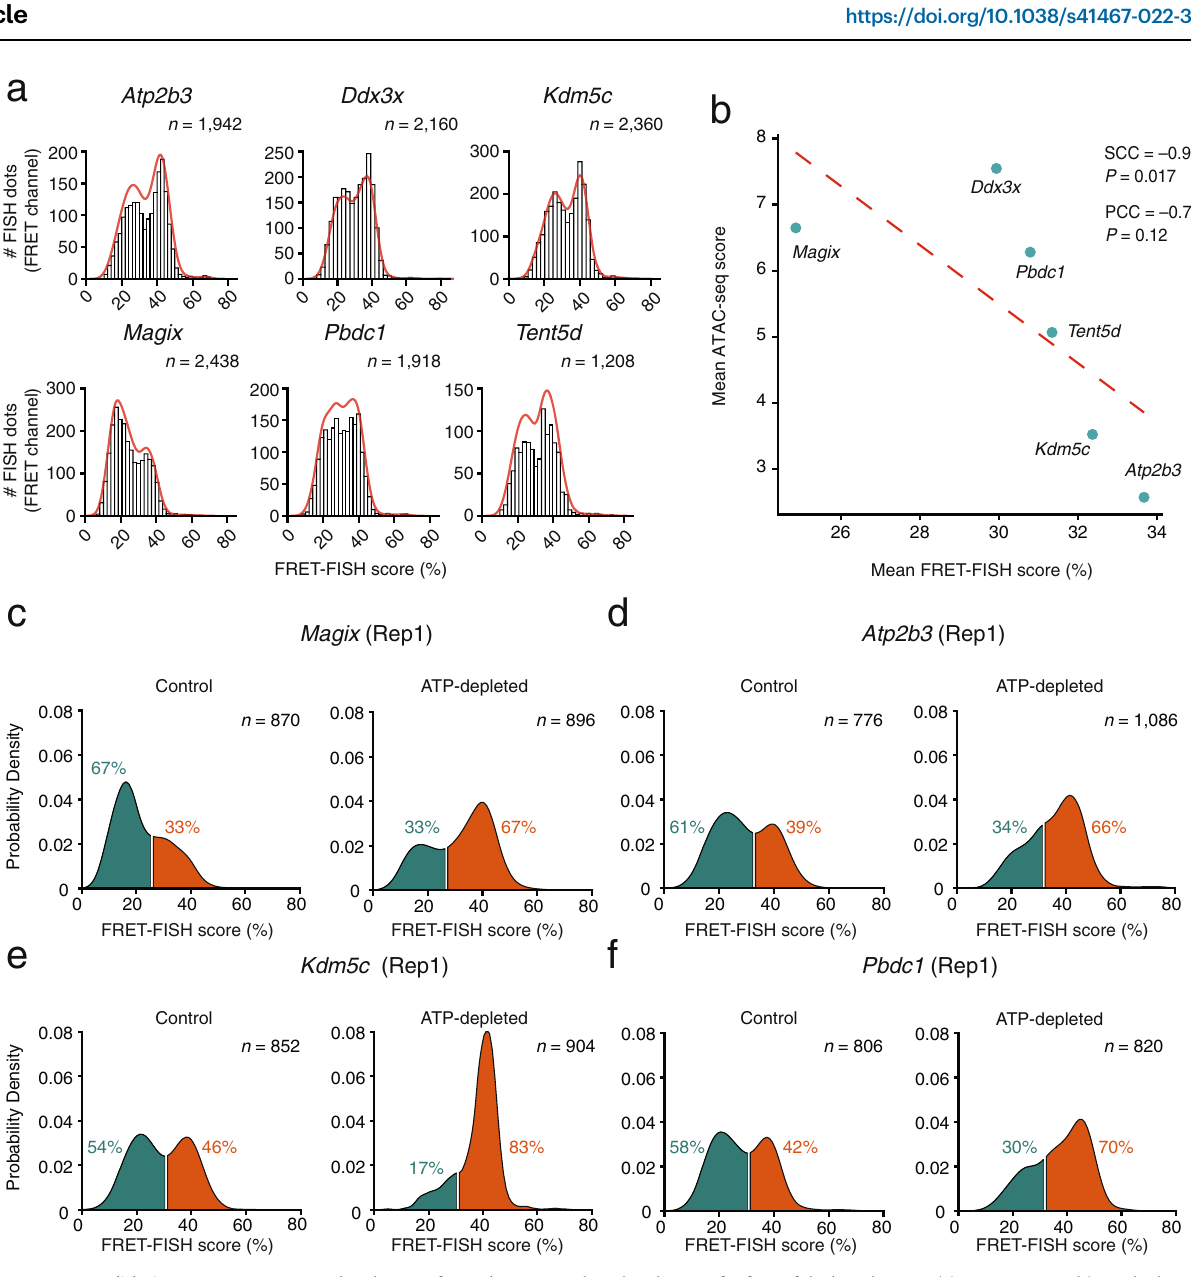
distributionsforfourofthelocishownin( a )inMEFstreated(ATP-depleted)ornot (Control) with sodium azide and 2-deoxy-d-glucose, in one of two replicate (Rep) experiments.Thein fl